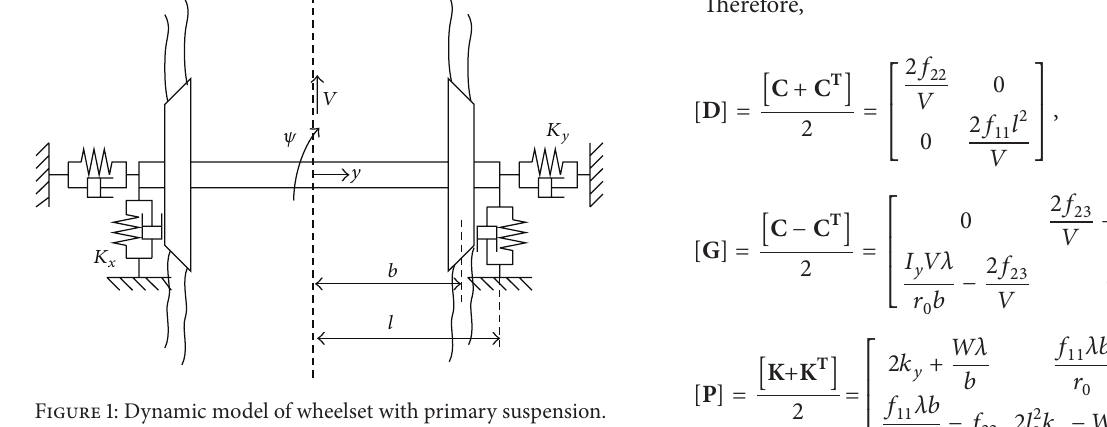
Figure 1: Dynamic model of wheelset with primary